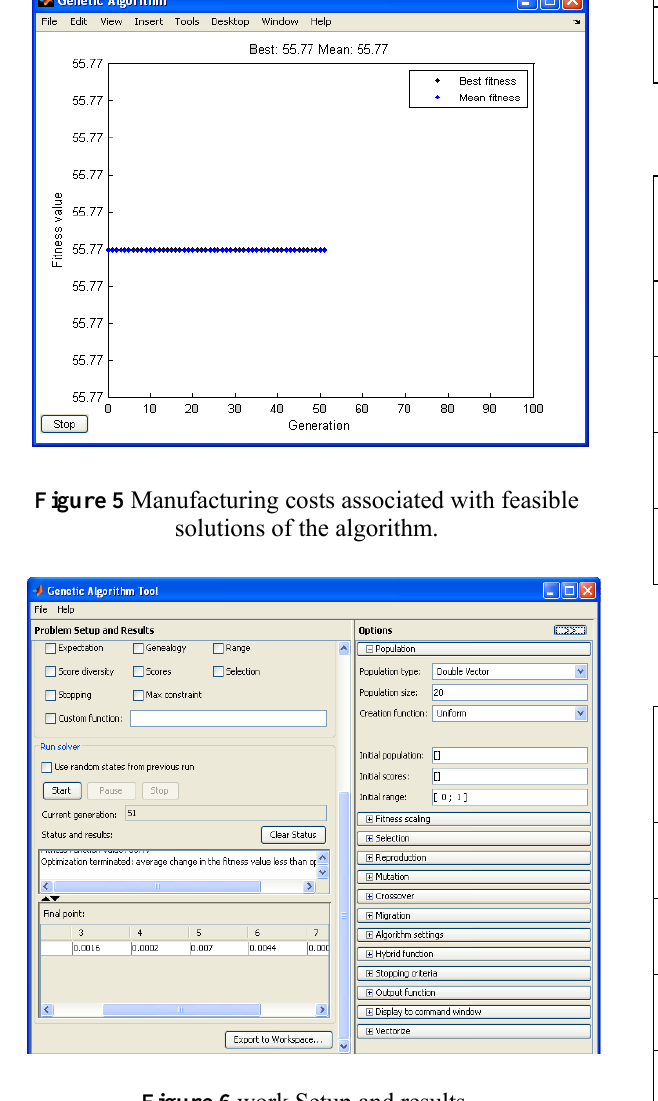
Figure 6 work Setup and results.